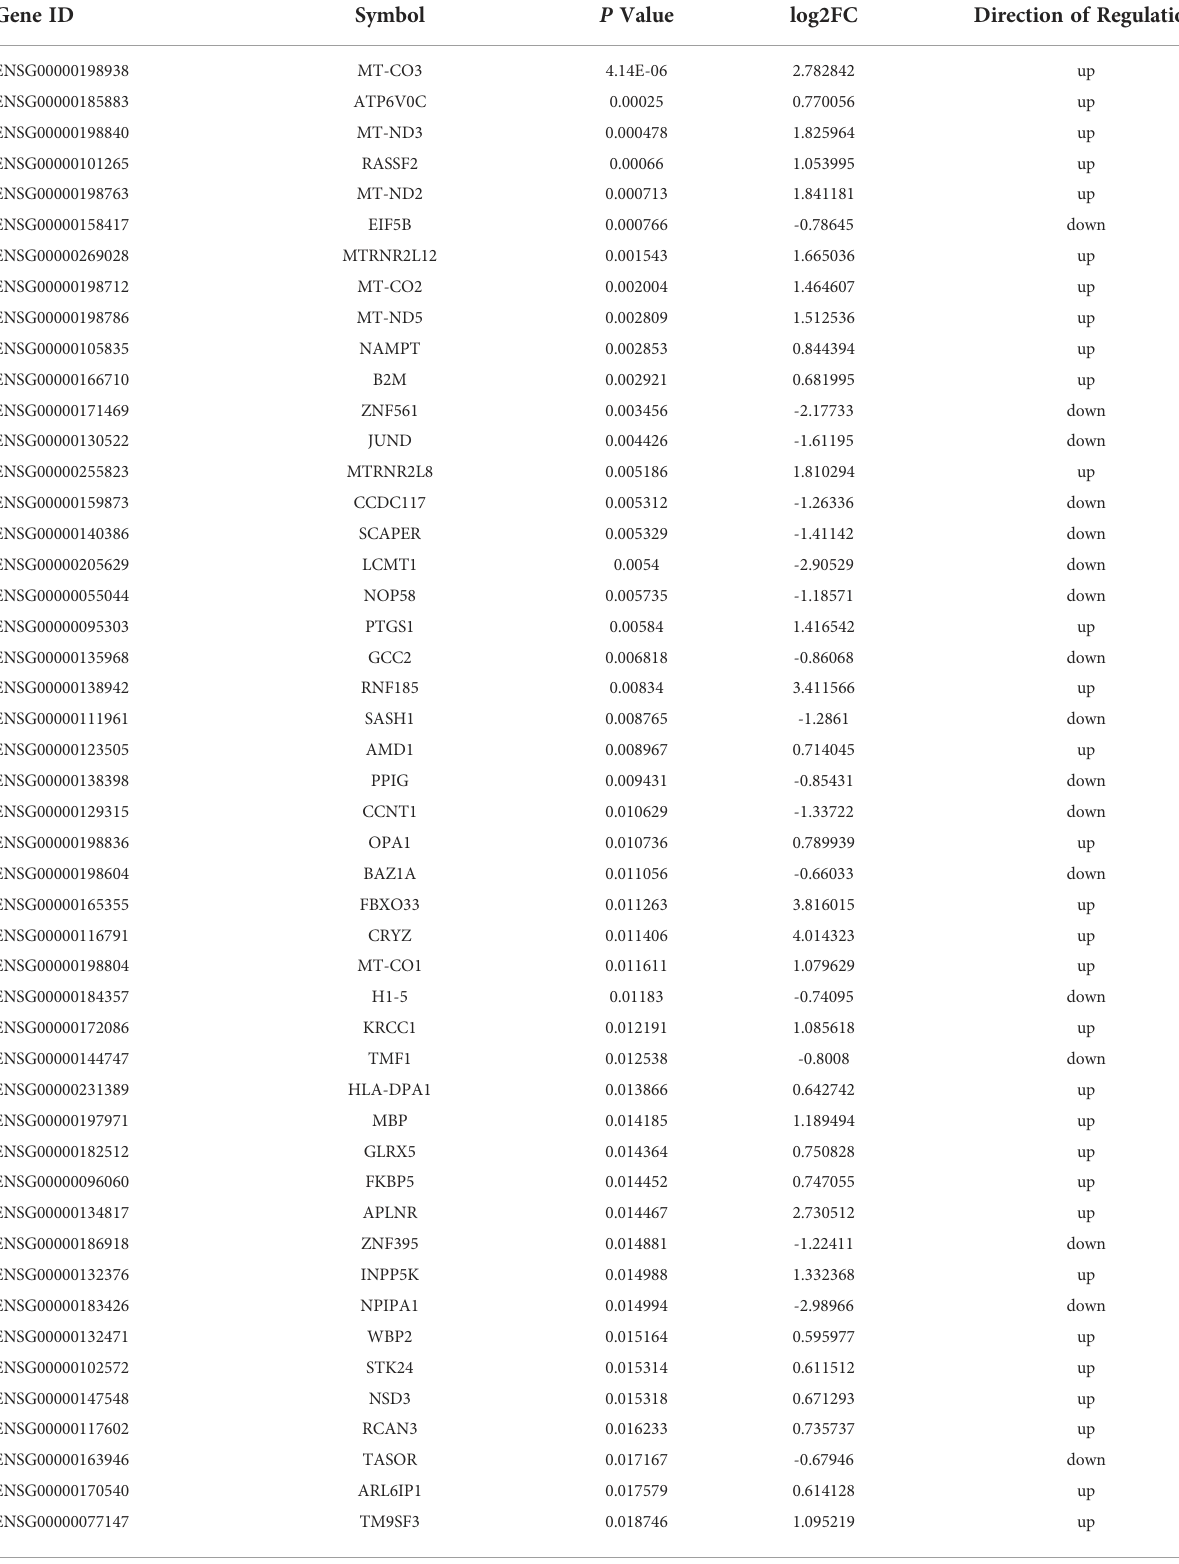
TABLE 3 Detailed information on the